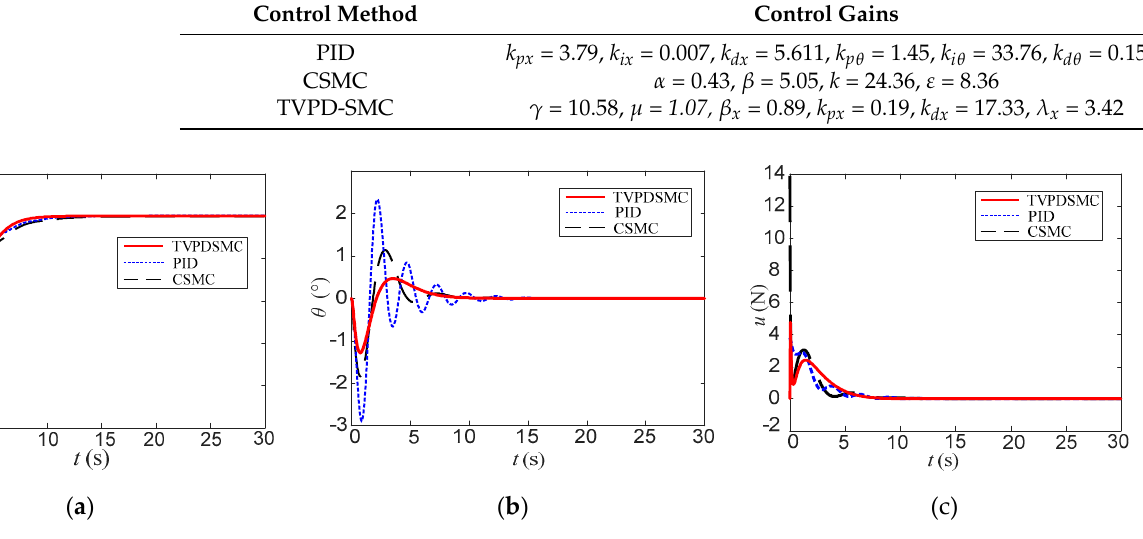
Figure 4. Simulation 2: System state variable response curve. ( a ) Trolley Displacement; ( b ) Payload Swing angle; ( c ) Driving force.